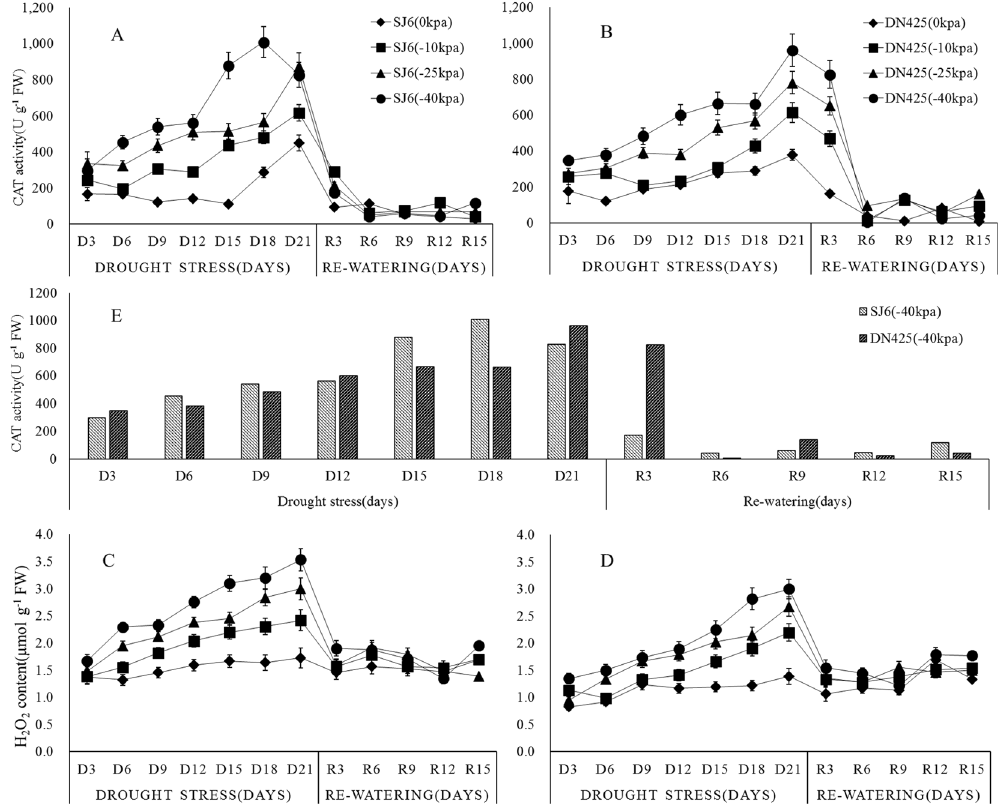
Figure 2. Effects of drought stress and re-watering on CAT activity ( A , B ) and H 2 O 2 ( C , D ) content in leaves at tillering stage of two rice cultivars in all treatments. The CAT activity of SJ6 and DN425 in − 40 kPa treatment ( E ). SJ6, Songjing 6 (drought-sensitive); DN425, Dongnong 425 (drought-tolerant). The values represent the means ± SD (n = 3). The experiment was conducted at Northeast Agricultural University farm,